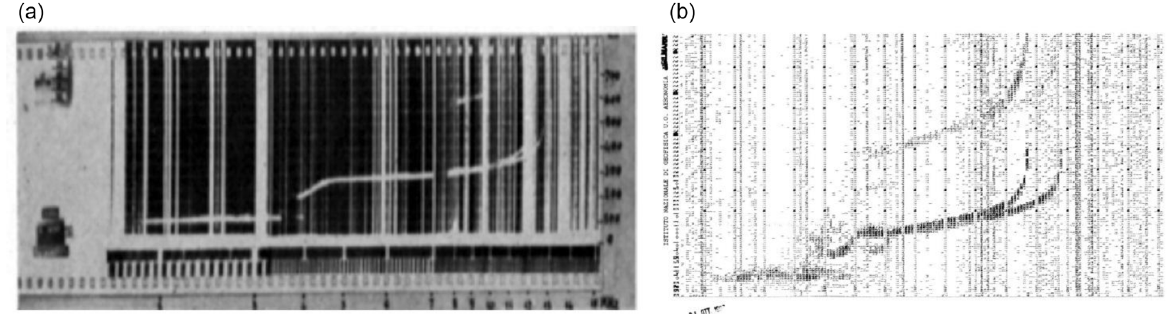
Figure 3. An old ionogram recorded on negative film is shown in ( a ): frequency is on a logarithmic scale. Panel ( b ) shows an ionogram from the first digisonde recorded on paper and tape: the intensity of the trace is proportional to the intensity of the received